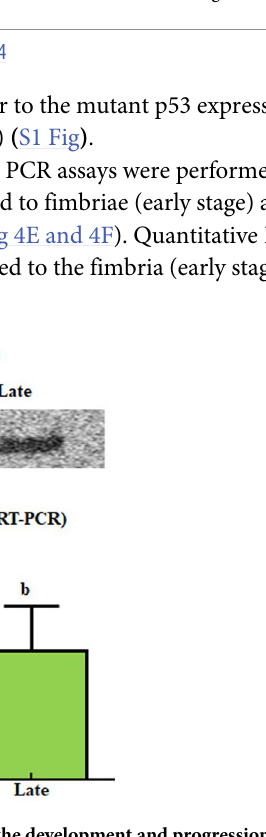
Fig 5. Changes in CA-125 expression during the development and progression of tumor in oviductal fimbriae in hens. A) Immunoblotting showed weak expression of CA-125 in normal fimbria. Compared with normal fimbria, strong signal for CA-125 was detected in fimbria with tumor at early stage and the signal was stronger in late-stage tumor. B) Quantitative gene expression (qRT-PCR) assays did not show significant increase in CA-125 levels with the progression of the disease to the late stages (P = 0.075). Fold change values are arbitrary values presented as mean ±